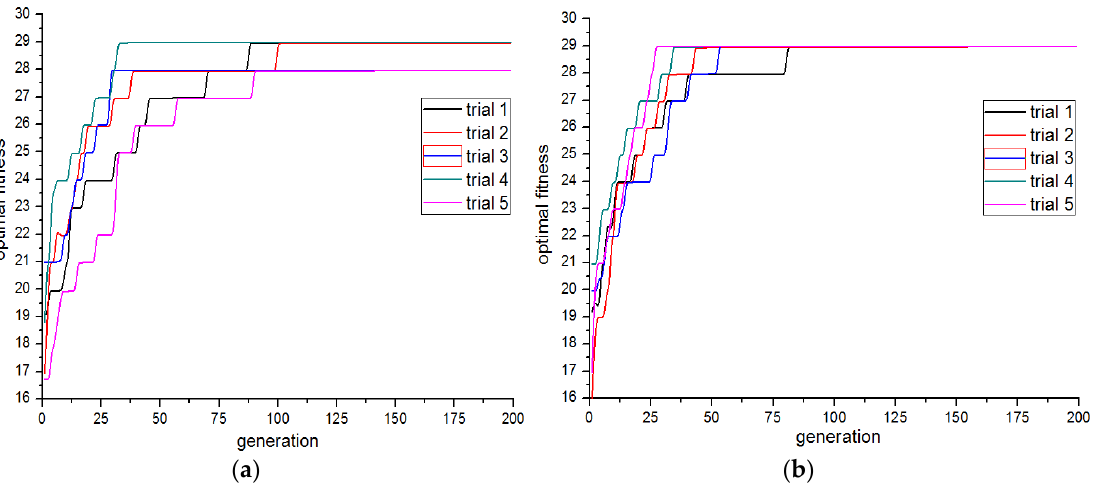
Figure 5. Comparison of optimization results: ( a ) GA without improvements; ( b ) GA with improvements. Table 4. Results comparison of 5 runs between original GA and improved GA for OF3 .